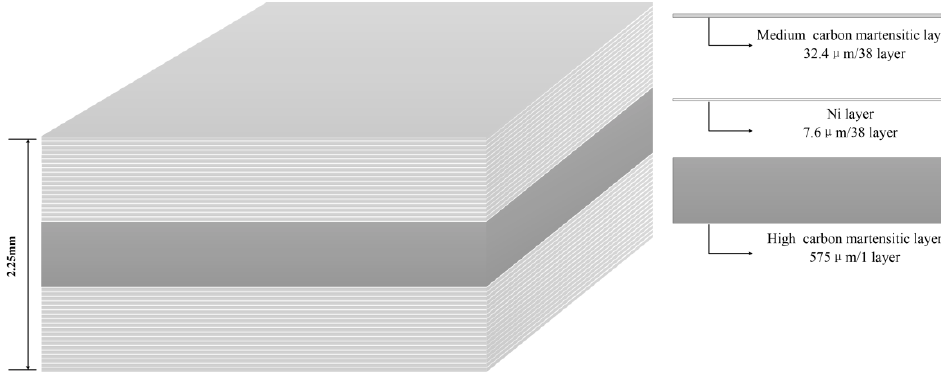
Figure 1. Schematic of as-received multilayered steel.